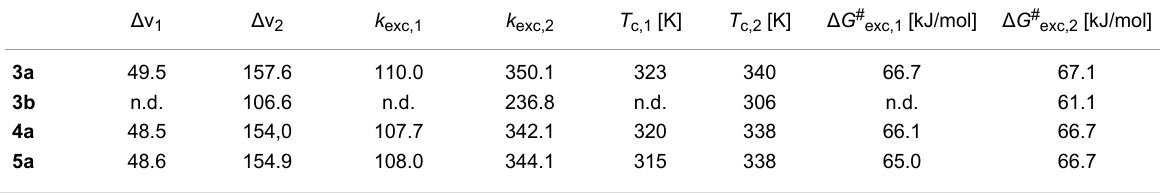
Table 2: Evaluation of the Gibb’s energy Δ G # exc of compounds 3a , 3b , 4a and 5a from NMR data measured in DMSO- d 6 .